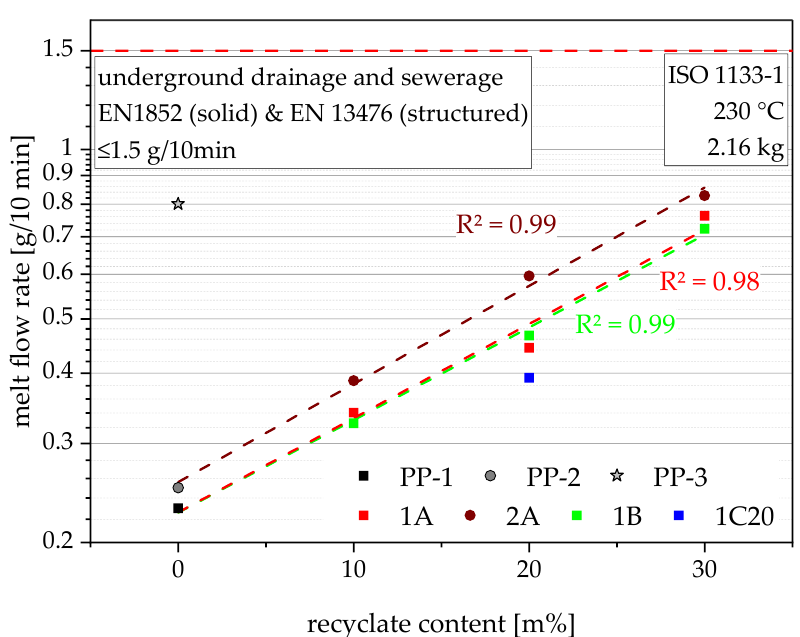
Figure 1. Graphical illustration of MFR values of the virgin blending partners PP-1 and PP-2, as well as the virgin injection molding grade PP-3 (as 0 m% recyclate content data points), and the compounds containing 10 m%, 20 m%, and 30 m% rPP-A, rPP-B, and rPO-C, respectively. Linear approximations of the compounding series 1A, 2A, and 1B are plotted as dashed lines, and the respective R 2 values are shown in the matching colors.